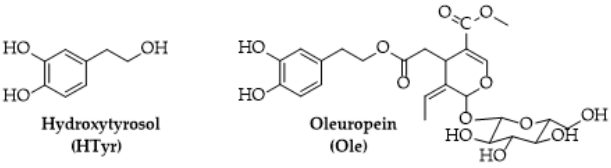
Figure 1. Chemical structure of hydroxytyrosol (HTyr) and oleuropein (Ole). During the production of extra virgin olive oil, a high quantity of wastes consisting of free-oil olive pulp (solid) and olive mill wastewaters (liquid) is obtained. Generally, 100 kg of extra virgin olive oil produce 400 kg of free-oil olive pulp and 100 kg of olive mill wastewaters [20]. The crushing of olive drupes releases endogenous β -glucosidases able to hydrolyze the ester bond present in Ole generating HTyr, which is partitioned between oil and water phases [22]. On the base of HTyr hydrophilic properties, this process tends to deplete HTyr from olive oil while enriching olive mill wastewaters: in fact, up to 214 mg of HTyr can be found per 1 kg of olive mill wastewaters [20]. Notably free-oil olive pulp and olive mill wastewaters represent a serious environmental problem, due to the high amount produced every year and the remarkable content in organic matter such as polyphenols, which are responsible for high toxicity [23]. For this reason, their disposal requires a significant economic effort to avoid severe environmental